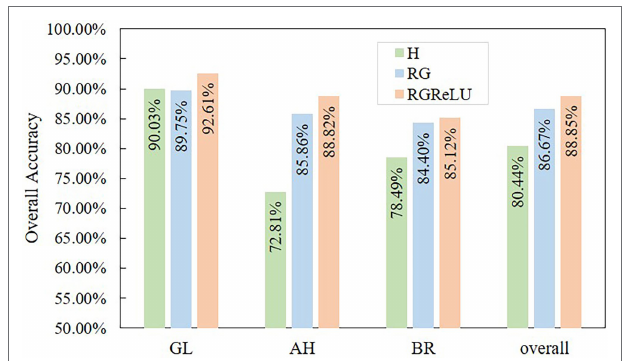
FIGURE 9 | The overall accuracy of scab